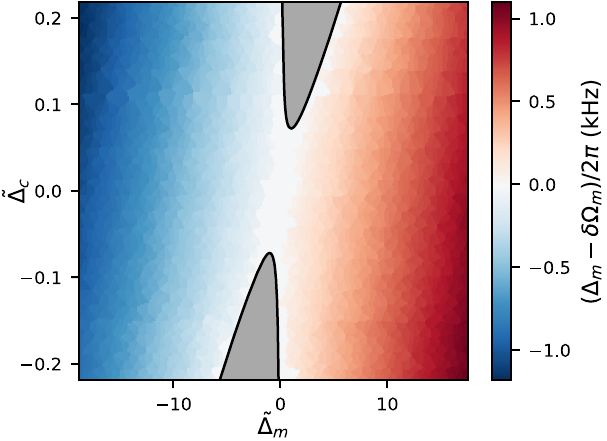
FIG. 6. Vanishing of the effective mechanical frequency. The plot shows the difference between the measured effective mechanical frequency and pump modulation frequency as a function of the detunings. Near the instability domain (shaded in gray), the two frequencies become equal, which corresponds to vanishing of the effective mechanical frequency in the rotating frame, confirming the theoretical treatment. Measurement is the same as in Fig. 4(b).